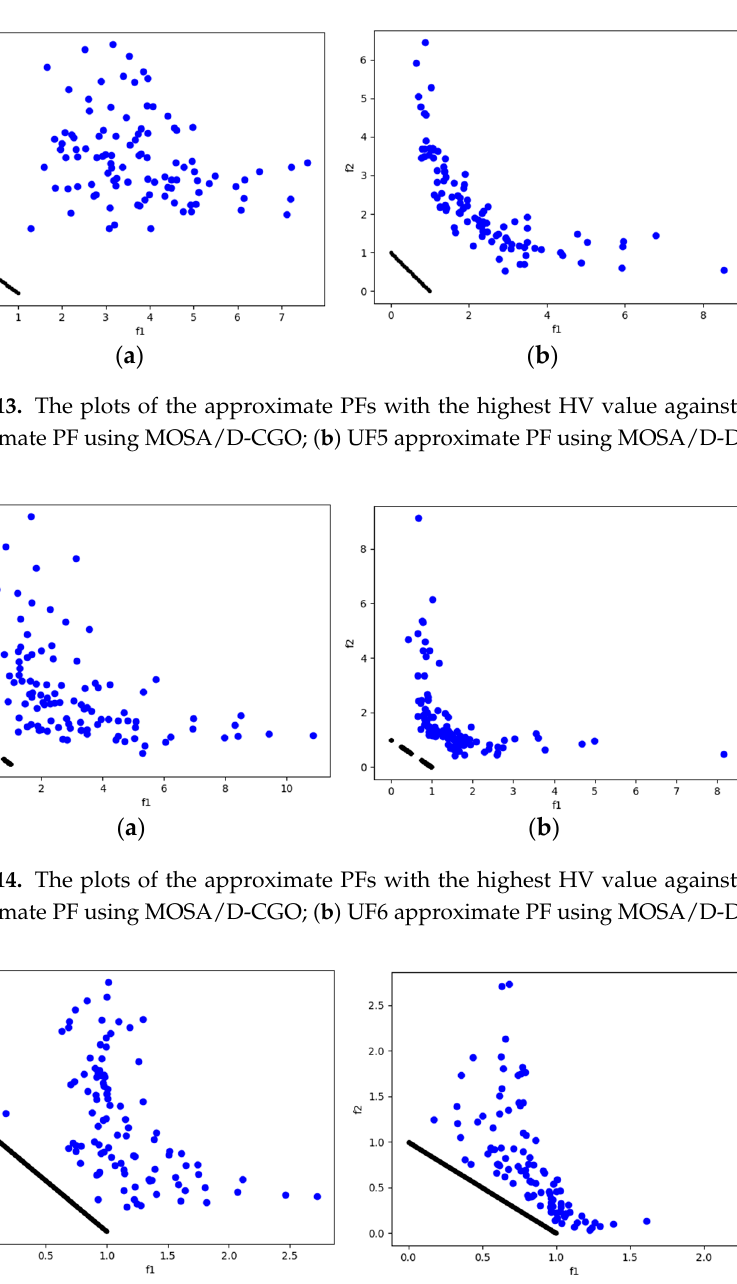
Figure 12. The plots of the approximate PFs with the highest HV value against real PF. ( a ) UF4 approximate PF using MOSA/D-CGO; ( b ) UF4 approximate PF using MOSA/D-DE.